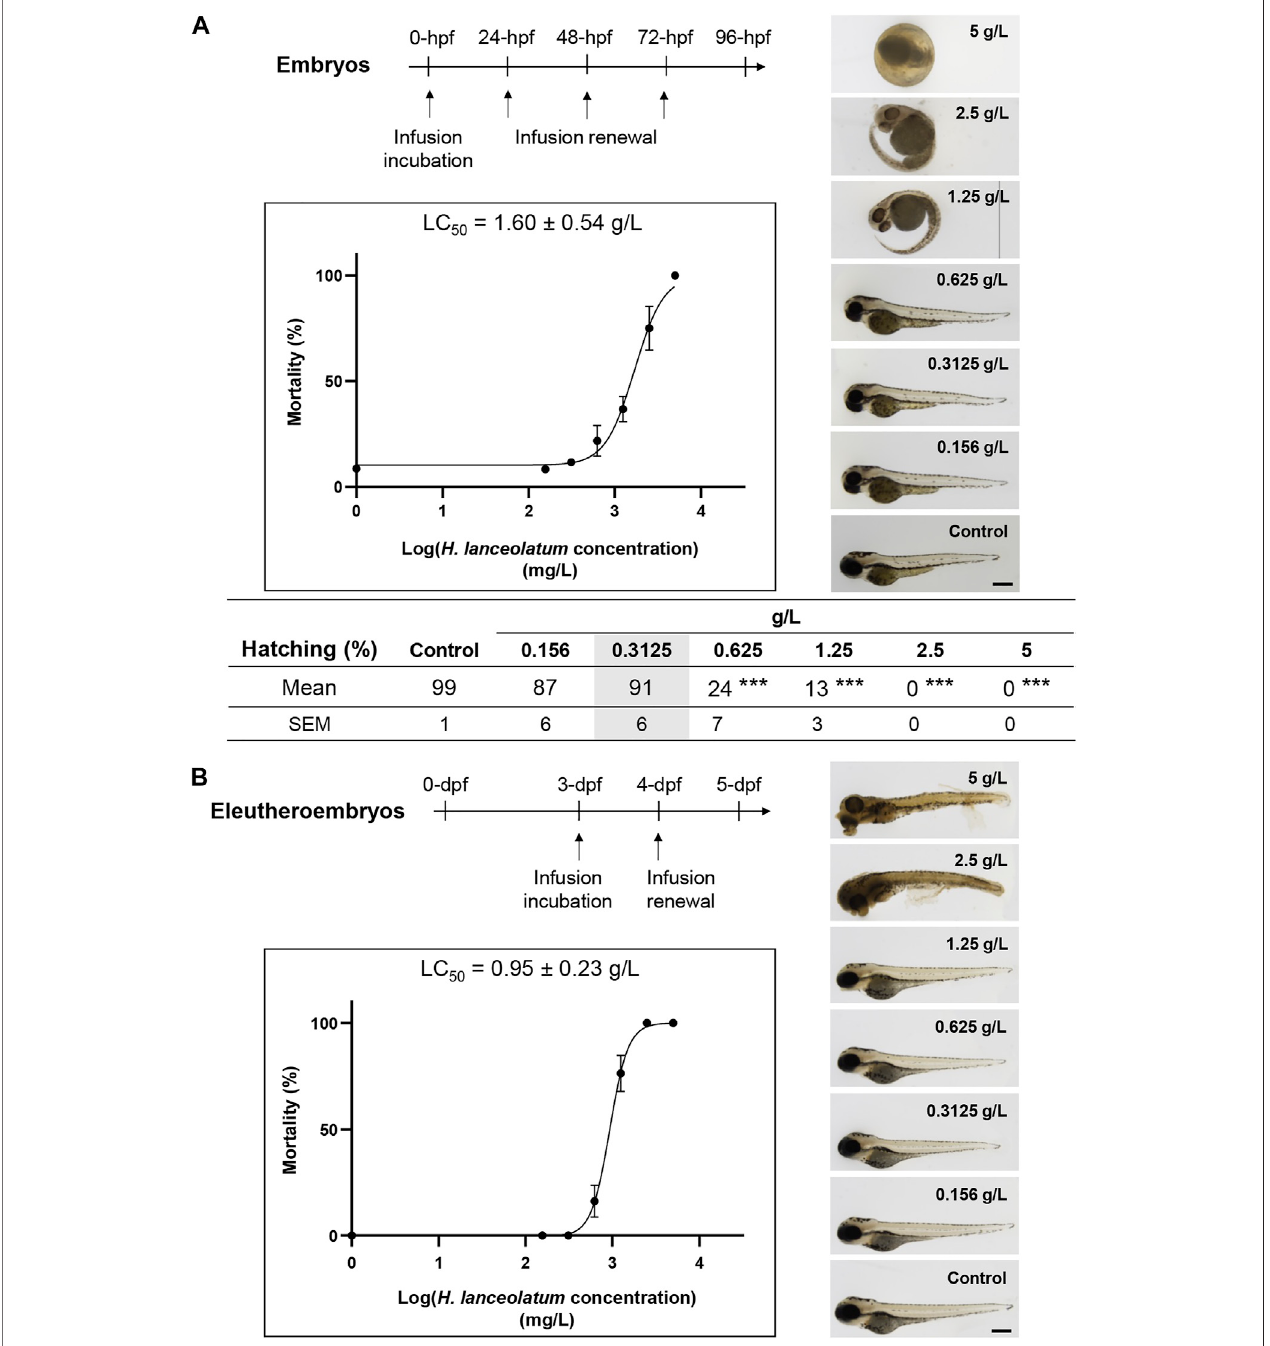
FIGURE 2 | In vivo acute toxicity assays in zebra fi sh embryos and eleutheroembryos. Toxicity curves, estimated median lethal concentrations (LC 50 ) and representative pictures of (A) 96-hpf embryos and (B) 5-dpf eleutheroembryos exposed to different concentrations of H. lanceolatum aqueous extract or E3 medium (Control).Curvevaluesareexpressedasmeans±SEM(n=60animals/groupfrom3independentexperiments).*** p < 0.001(Studentt-test).Bar=350 µm.Notethatin (A) ,at 5 g/Lall theembryos aredead at 24-hpf. For2.5and 1.25 g/Laround 26and 63%ofeleutheroembryoswerealive at 96-hpf, respectively. The shaded area represents the